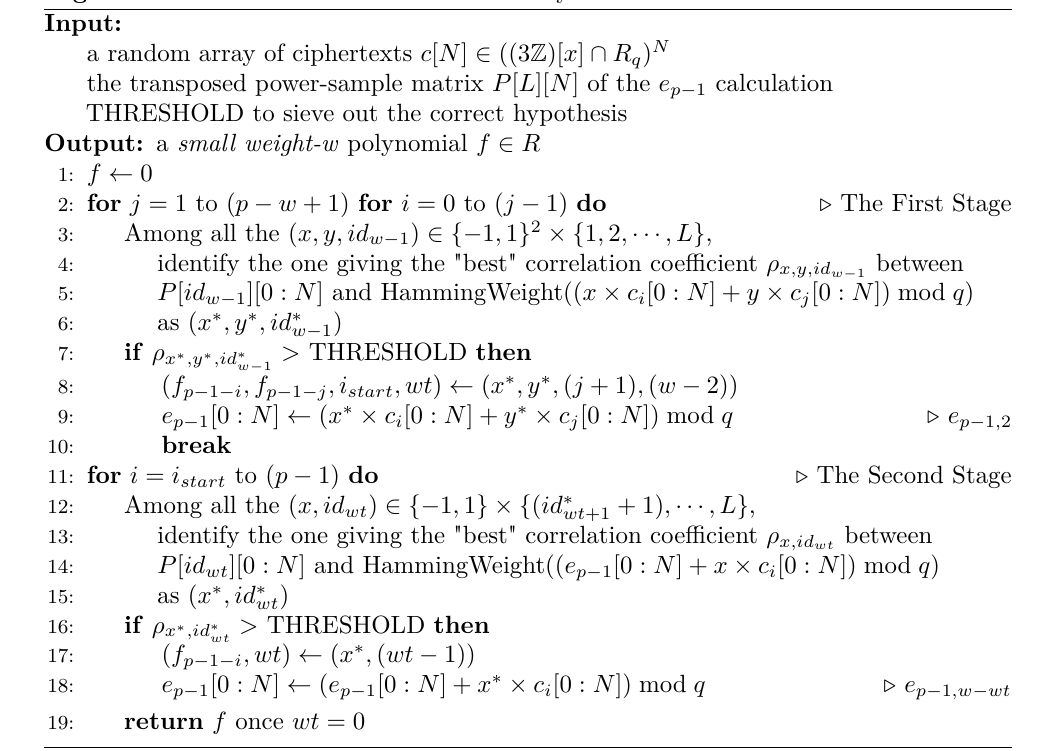
Algorithm 1 Vertical Correlation Power Analysis on NTRU